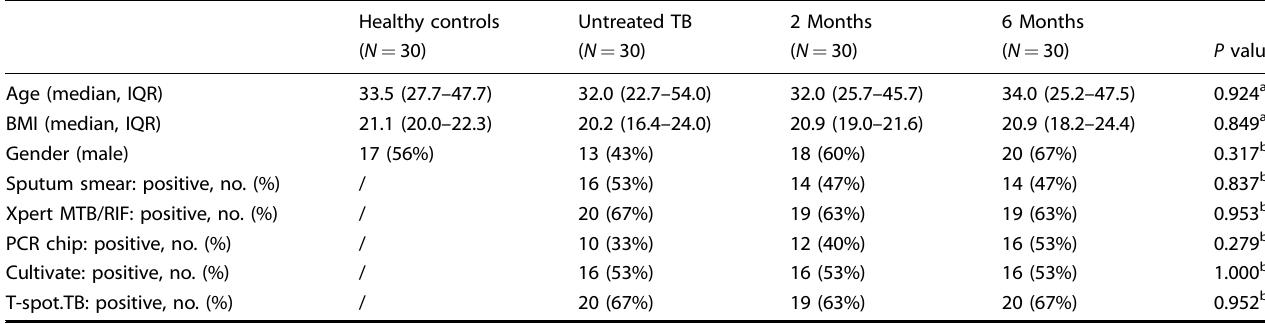
Table 1. Statistics of clinical characteristics and laboratory indexes of the study cohort Healthy controls Untreated